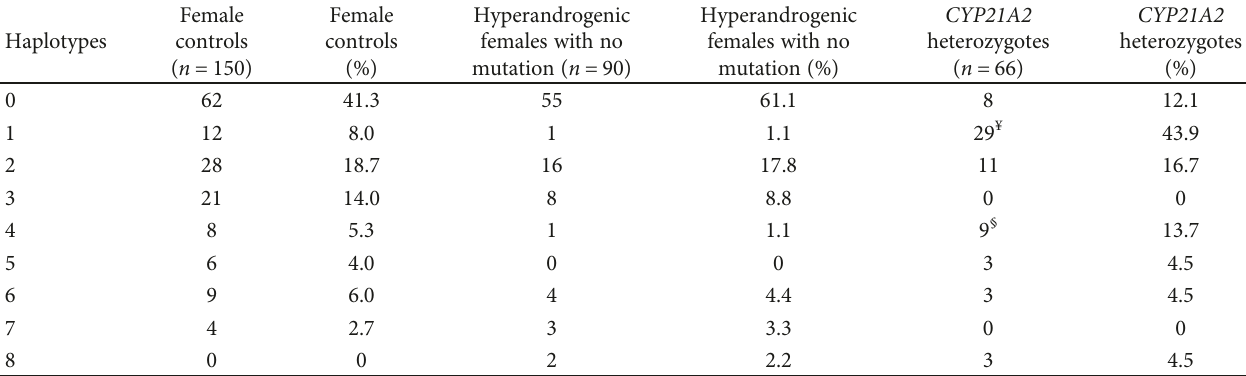
Table 2: Haplotypes of the alleles with the variants found in the 3 ′ UTR of the CYP21A2 gene.